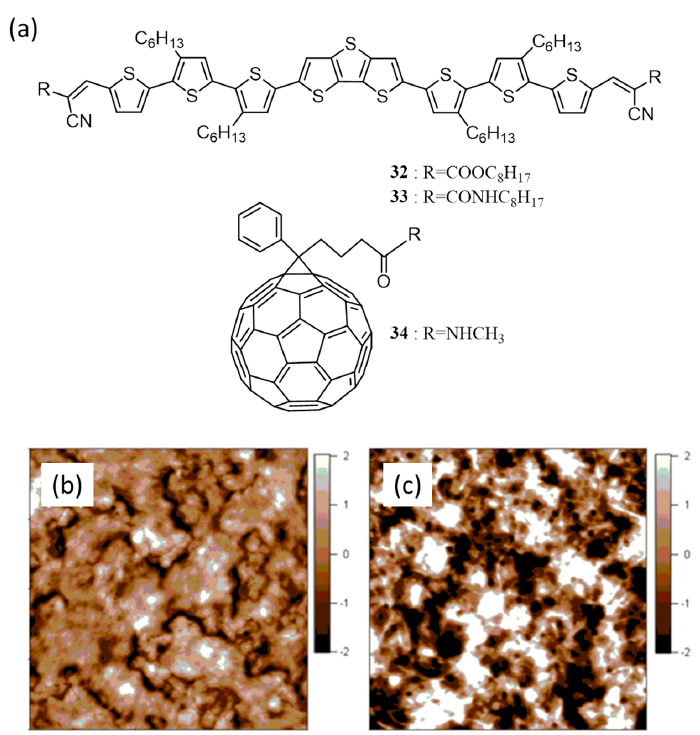
Figure 13. ( a ) The structure of the oligomers 32 – 34 synthesized by Wong et al. [60]. AFM height images of spin coated films from 10 mg·mL − 1 chloroform solution of ( b ) 32 and ( c ) 33 . Adapted with permission from Ref. [60] Copyright 2014 Nature Publishing Group.